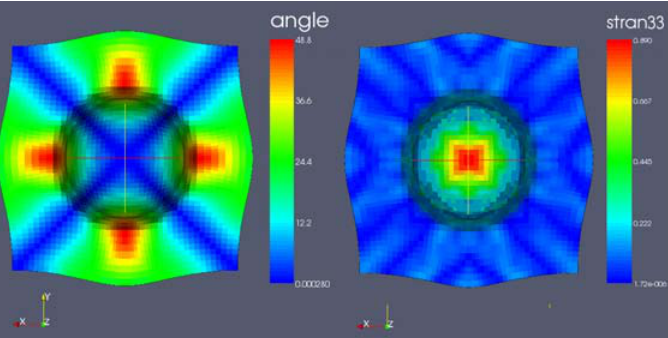
Fi g 10: Change of angle Fig 11: Normal